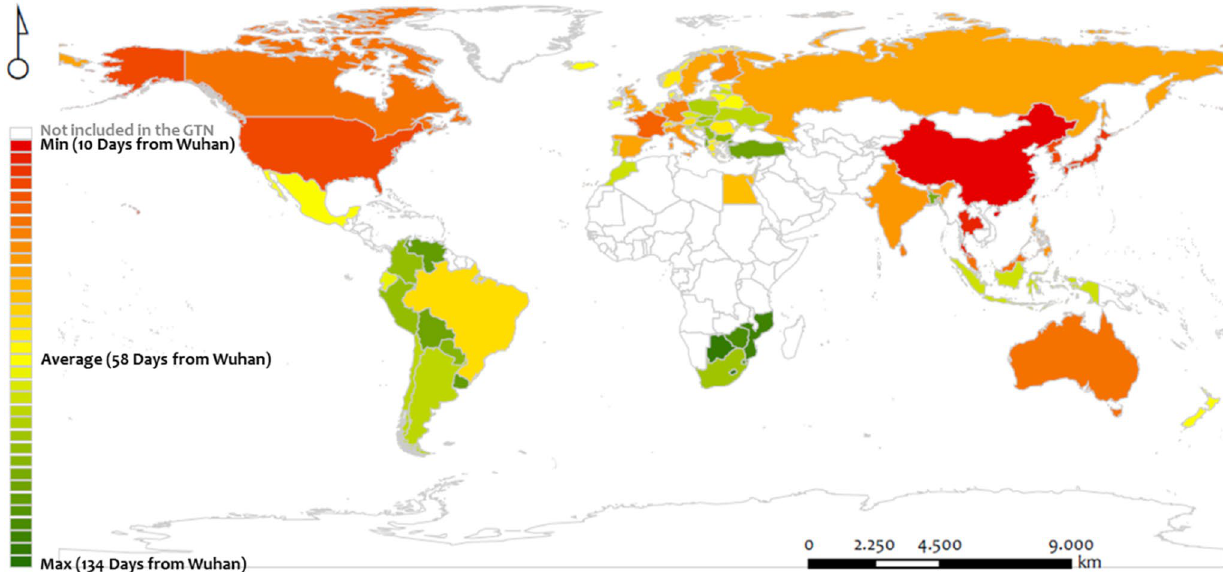
Figure 3. Heat map illustrating the spatial distribution of the temporal spread variable ( DFW ) expressing the number of days from Wuhan (dfW) since the first case emerged in a country (the days of the first infection per country), for the countries included in the GTN (own elaboration based on ESRI ArcGIS 10.50; https:// www. arcgis.